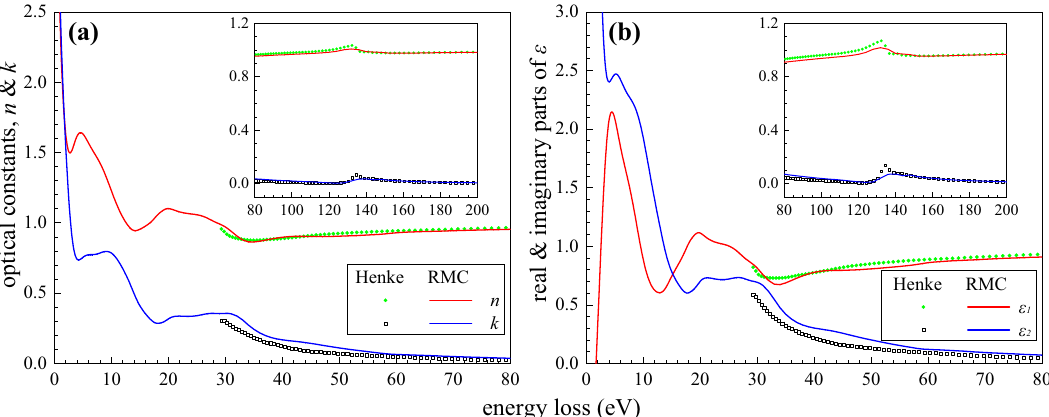
Figure 3. ( a ) A plot of the refractive index n (red) and extinction coefficient k (blue) of Sm derived from ELF by the RMC analysis. Optical experimental data 22 (dots and squares for n and k , respectively) are shown for a comparison; ( b ) A plot of real part ε 1 (red) and imaginary part ε 2 (blue) of the complex dielectric function of Sm derived by the RMC method. Data given in Ref. 22 (dots and squares for ε 1 and ε 2 , respectively) are shown for a comparison.